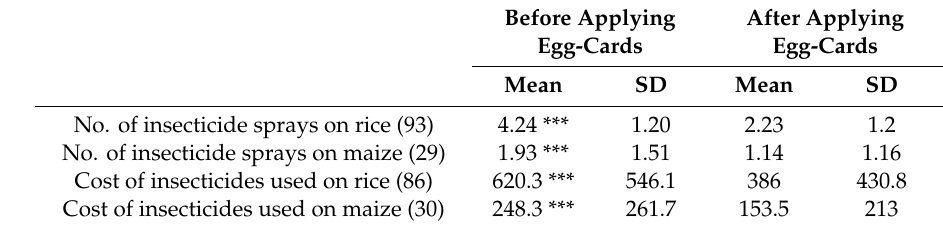
Table 7. Rice and maize farmers’ reported benefits of using Trichogramma egg-cards during the HHS, comparing the situation in 2016 and 2017, i.e., before and after applying egg